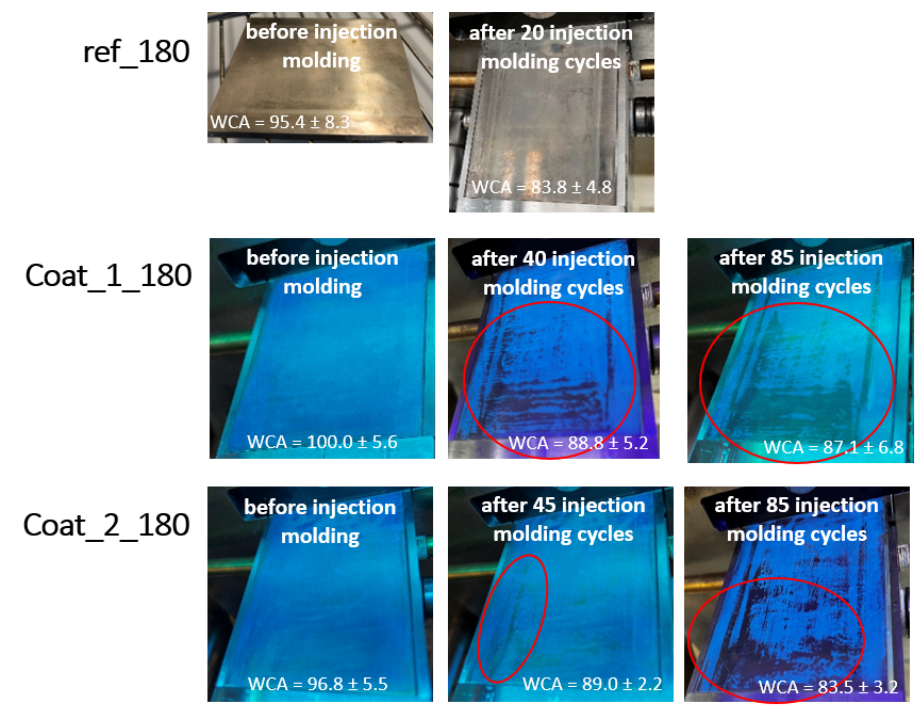
Figure 10. Demonstration of abrasion and wear of the coatings ref_180, coat_1_180 and coat_2_180 on steel plates during the injection molding process. The corresponding water contact angles (WCA) are given at the bottom of each